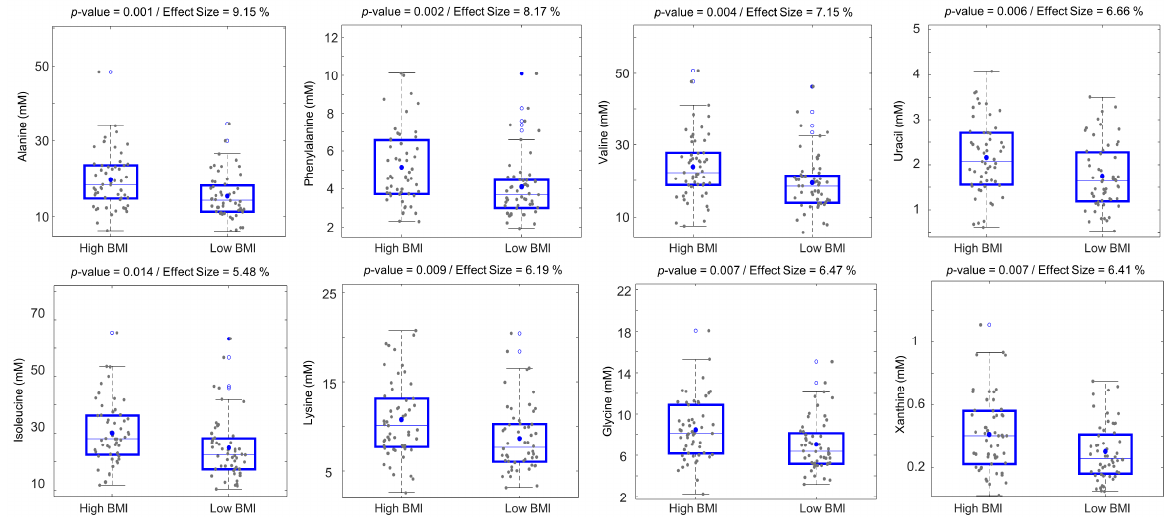
Figure 3. Boxplots of selected human fecal metabolites that are different between low-BMI (<23.5, n = 54) and high-BMI (>27, n = 55) groups. p -values and effect sizes (%) were calculated from ANOVA. The horizontal lines and dots inside the boxes represent median and mean values, respectively. Blue circles and blue-filled circles correspond to quartiles >75% and 95%, and 95%, respectively.